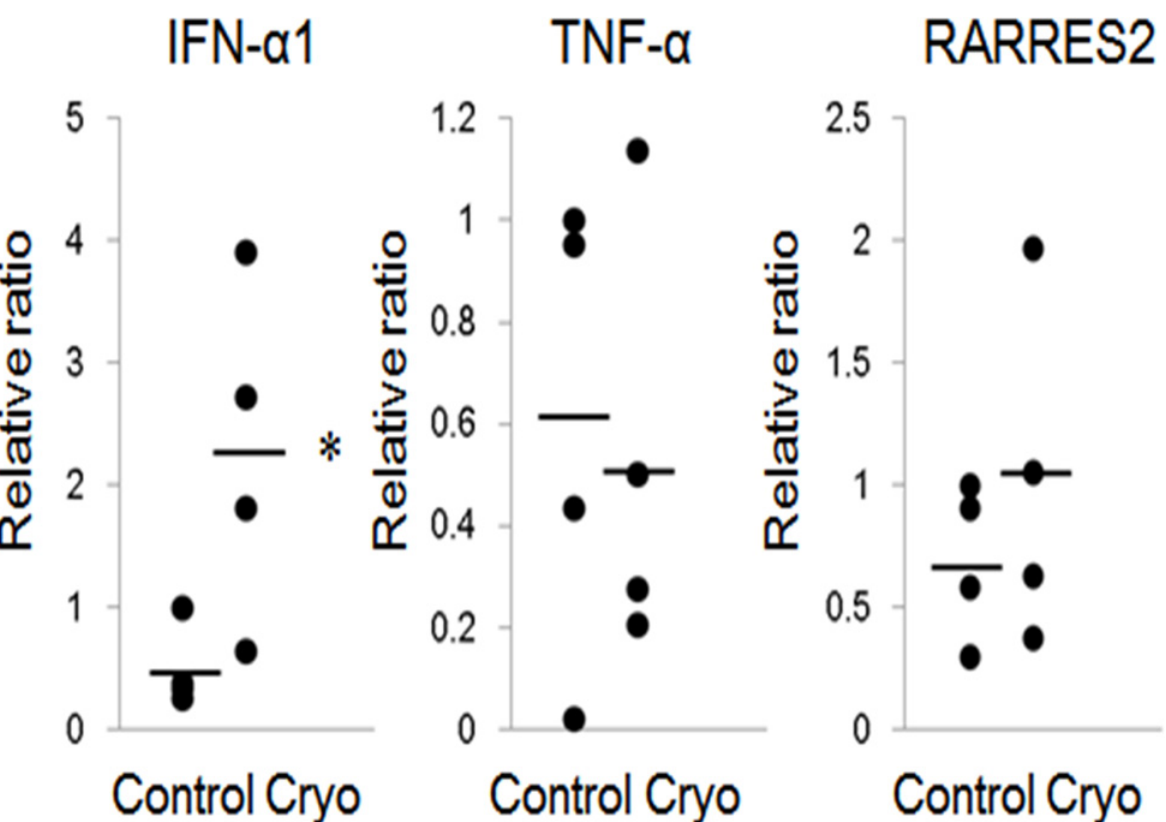
Fig 5. mRNA expression in the skin treated with cryoablation. The mRNA expressions of IFN- α 1, TNF- α , and RARRES2 were measured by real time PCR analysis at day 1 in 15-sec cyoablated skin. The levels of TNF- α , and RARRES2 (potent chemoattractant of pDCs), were not increased by cryoablation. Cryo, cryoablation. All data are shown as dots. Bars represent the mean values. Significant differences between the means are indicated, * P < 0.05 versus control. n = 4, in each group.